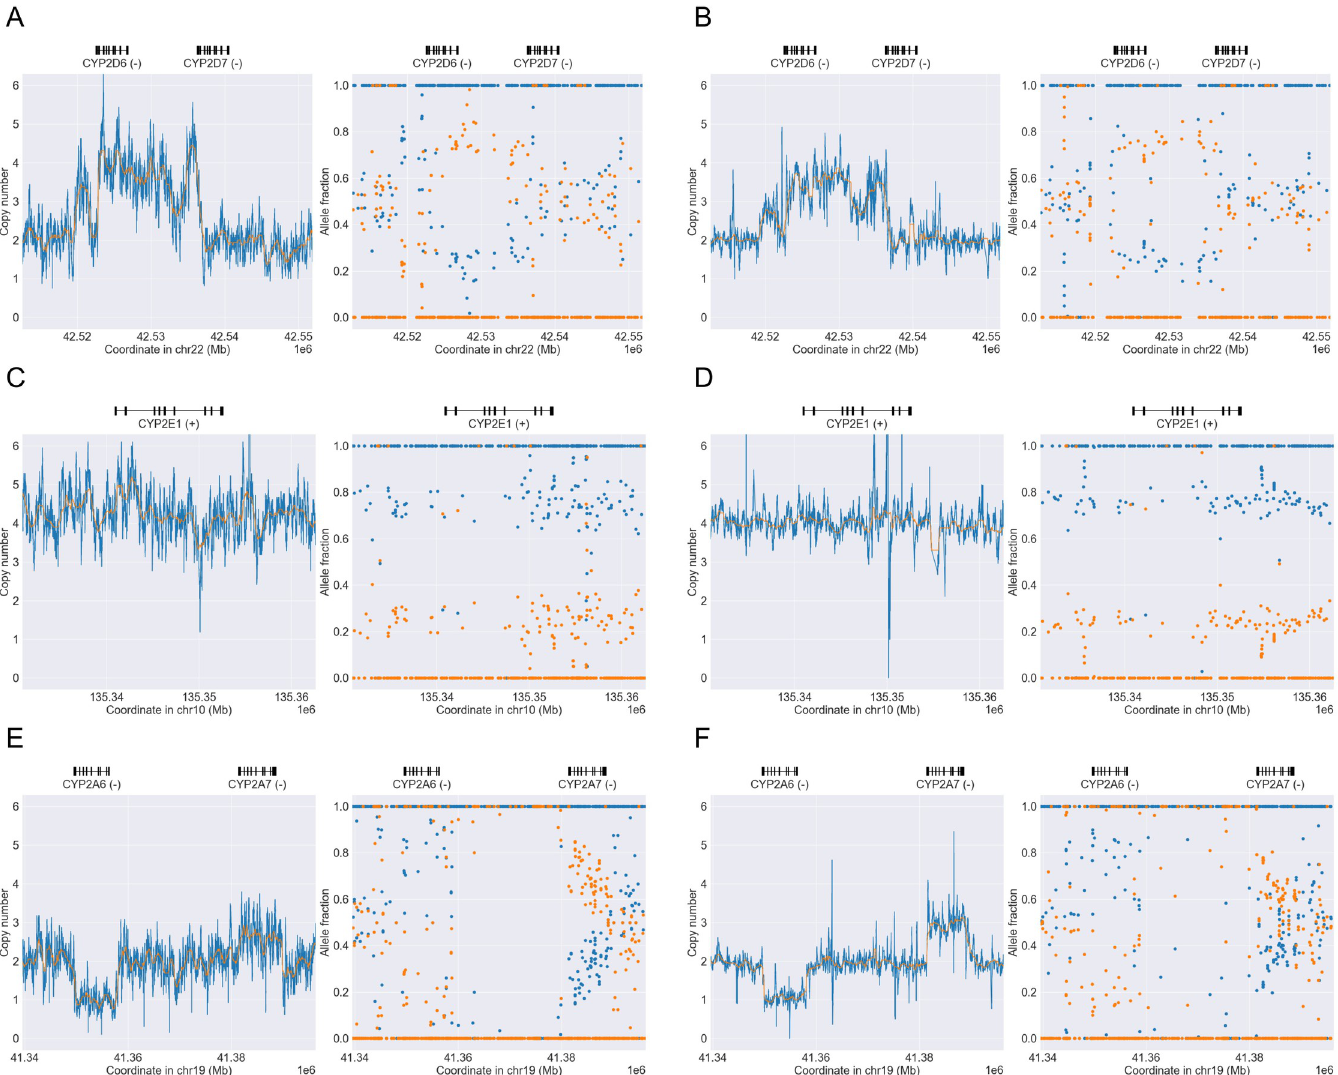
Fig 5. Examples of diplotype discrepancy caused by difference in SV interpretation between this study and previous publications. WGS data are shown in the left panels (A, C, and E) while ClinPharmSeq data are shown in the right panels (B, C, and D). Each panel contains a copy number profile and an allele fraction profile created by PyPGx. (A-B) East Asian sample NA18540 was previously identified to have three CYP2D6 gene copies in total with a CYP2D6( � 36+)10/ � 41 diplotype, but this study identified four gene copies with a CYP2D6 � 36x2+ � 10/ � 41 diplotype. (C-D) African sample NA19908 was previously suggested to have a CYP2E1 � 7x2/ � 7x2 diplotype (i.e. allele fraction ratio of 2:2), while this study found evidence of a CYP2E1 � 7/ � 7x3 diplotype (i.e. allele fraction ratio of 1:3). (E-F) East Asian sample HG00436 was previously genotyped to have a combination of one known SV ( CYP2A6 � 4 ) and one novel SV ( CYP2A6 � 1+ � S6 ), while in this study PyPGx produced an ‘Indeterminate’ diplotype call because it could also be just one novel SV, which would be a more parsimonious explanation.